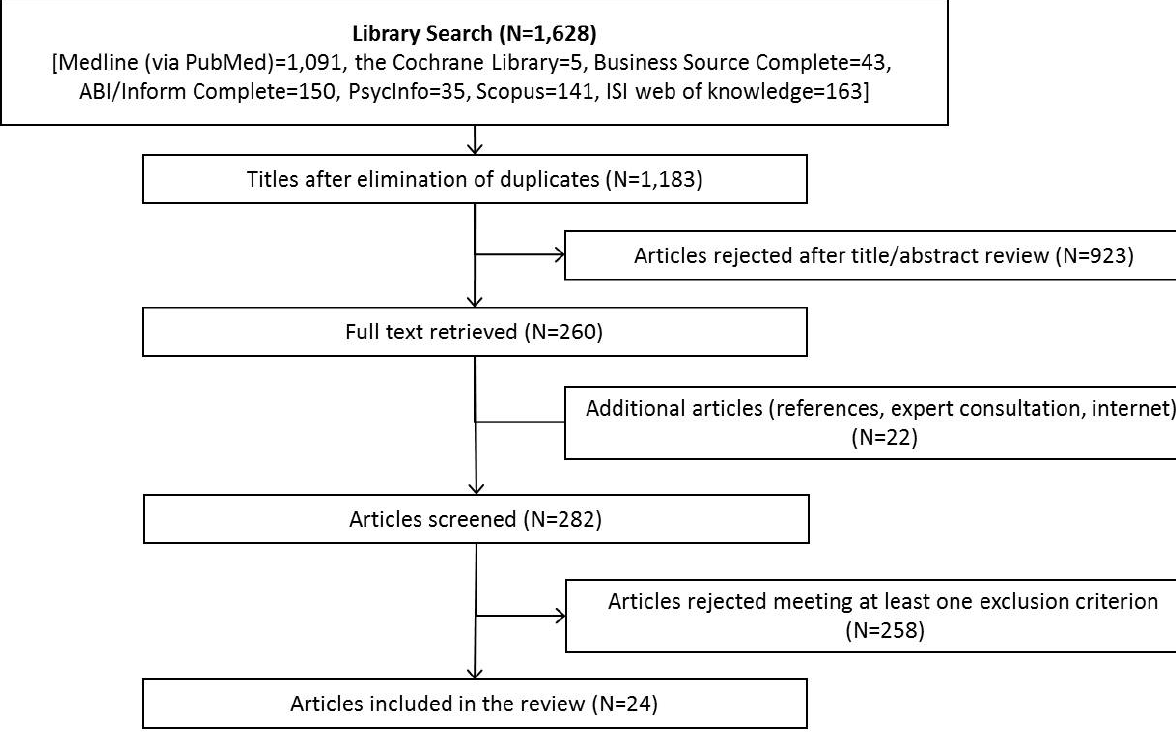
Figure 1. Search